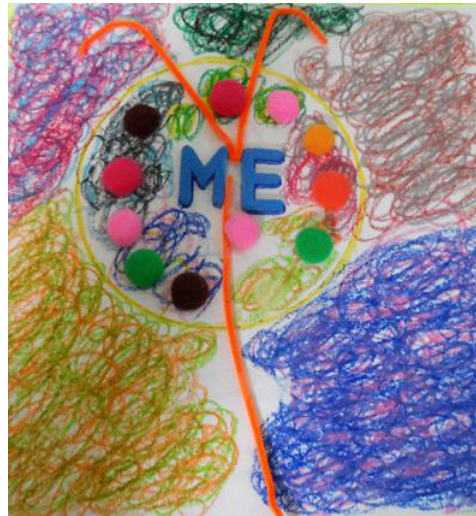
Figure 2. Aqueelah’s drawing of her experience of the emerging